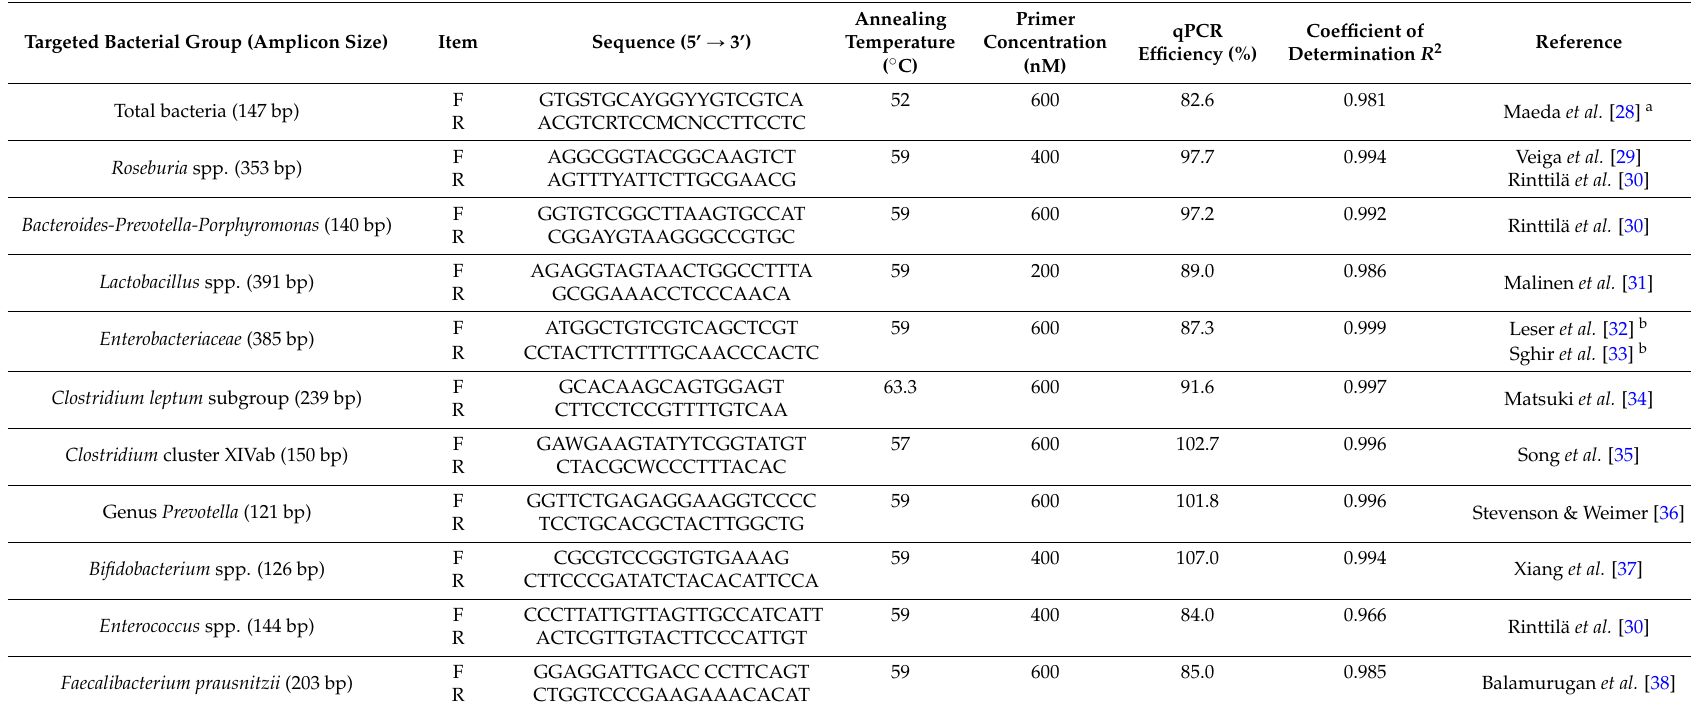
Table 2. Oligonucleotide primers used for real-time